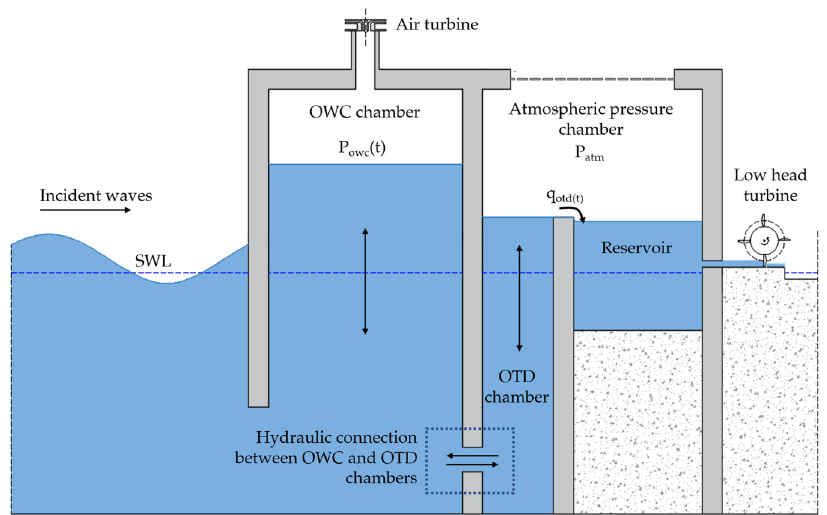
Figure 1. Sketch of the functioning of the O 2 WC hybrid device.